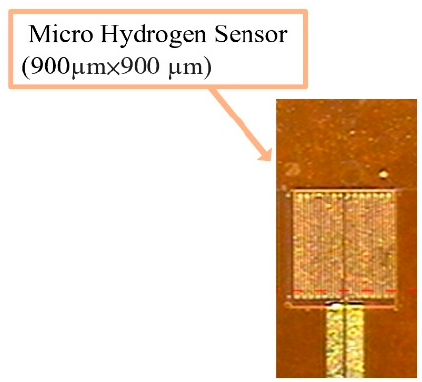
Figure 1. Optical micrograph of flexible micro hydrogen sensor. Figure 2. Optical micrograph of flexible micro hydrogen sensor.